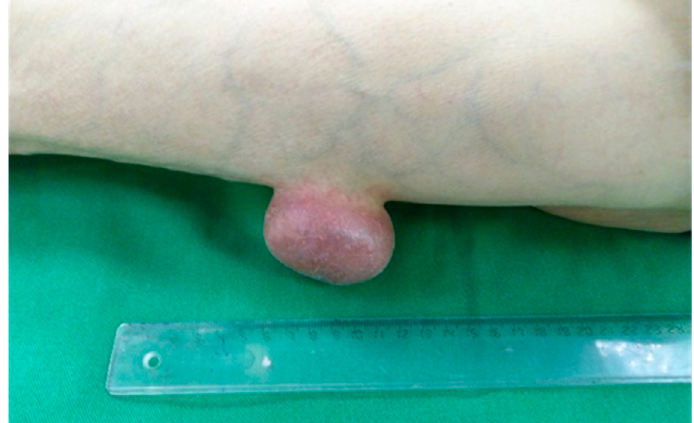
Figure 1. Left leg with a 5.6 nodular formation.